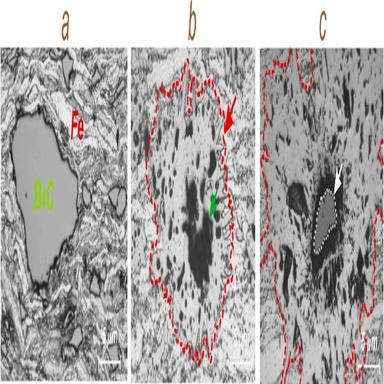
a) Distribution of the B4C reinforcement particles in the Fe matrix before sintering, b) Formation of diffusion zones (red dotted line) around completely diffused smaller B4C particles, and porosity (green arrow), c) formation of residual B4C particles (white dotted line). (For interpretation of the references to colour in this figure legend, the reader is referred to the Web version of this article.)